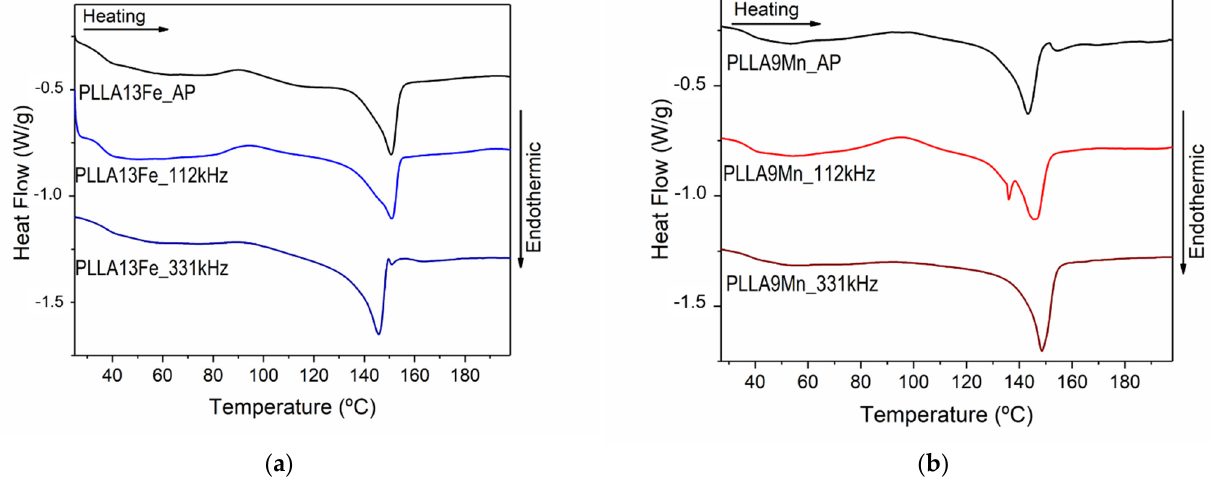
Figure 7. DSC scans of composites before and after EMF treatments at 112 and 331 KHz: ( a ) PLLA reinforced with 12.7 wt% of γ -Fe 2 O 3 MNPs and ( b ) PLLA reinforced with 8.7 wt% of MnFe 2 O 3 MNPs.